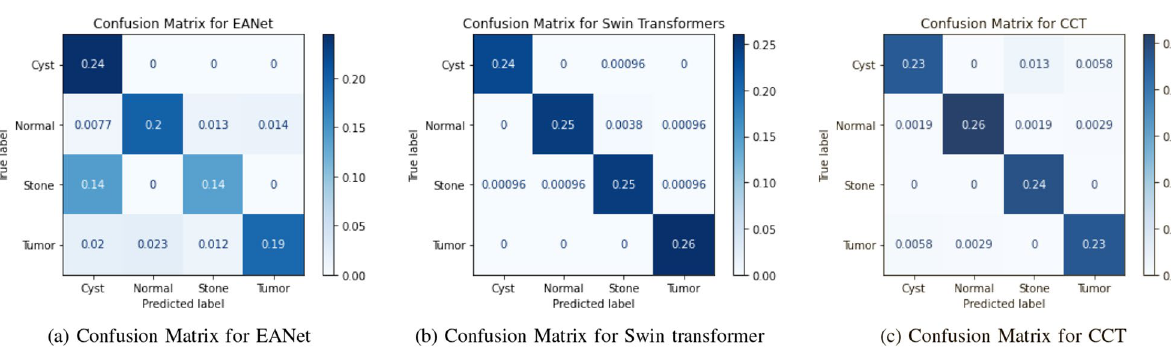
Figure 13. Confusion Matrices for Transformer Based Models Used in Our